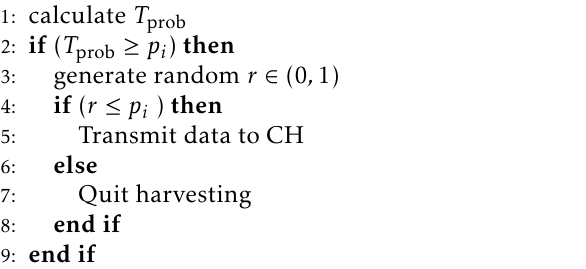
Algorithm 2 Opportunistic Transmission